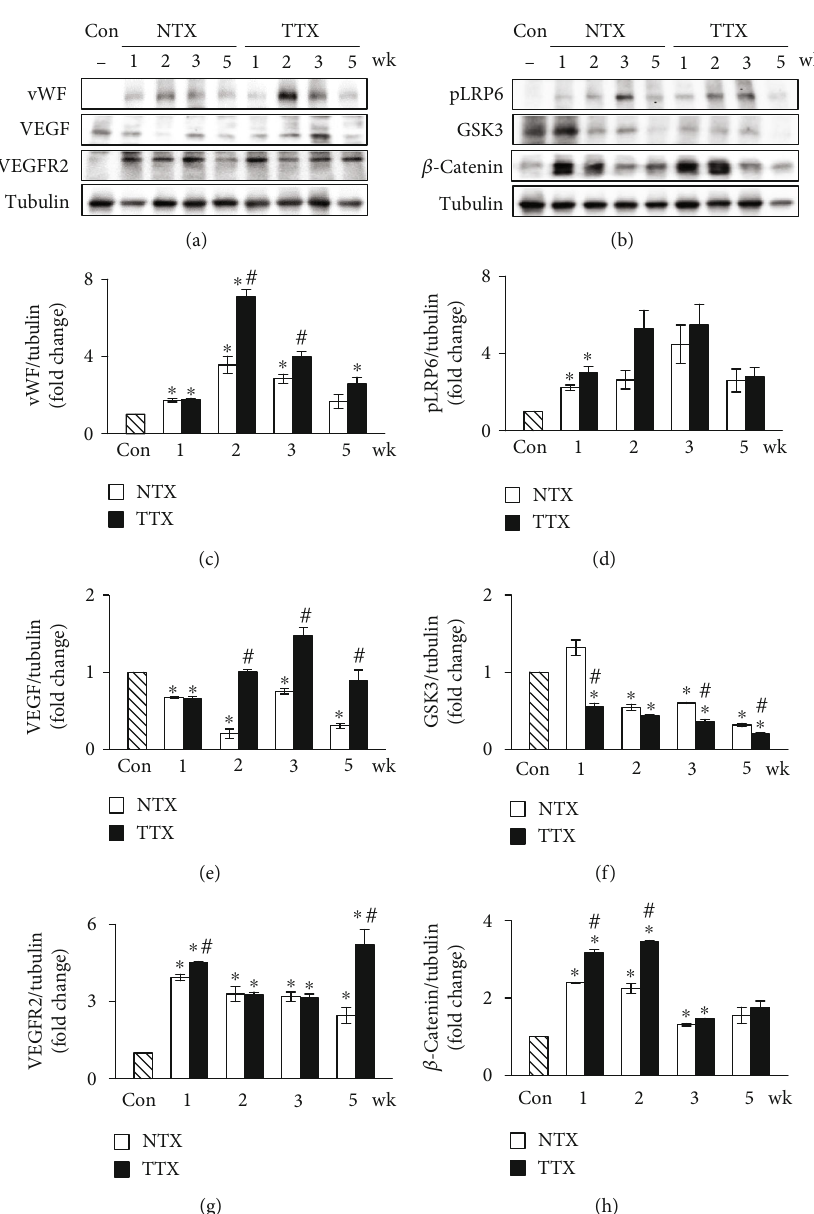
Figure 2: Induced Wnt signaling and angiogenesis by PD-MSC transplantation in BDL rats. Angiogenesis (a) and Wnt signaling (b) factors were detected in rat liver tissues after PD-MSC transplantation. Graph of intensity was normalized to that of tubulin for vWF (c), VEGF (e), VEGFR2 (g), pLRP (d), GKS3 (f), and β -catenin (h) ( n = 2 per group, ∗ Con and # NTX vs. p < 0 : 05 ). Data were represented as the mean ± SD . vWF: von Willebrand factor; VEGF: vascular endothelial growth factor; VEGFR2: vascular endothelial growth factor receptor 2; Con: control group; NTX: PD-MSC nontransplanted group; TTX: PD-MSC transplanted group; wk: